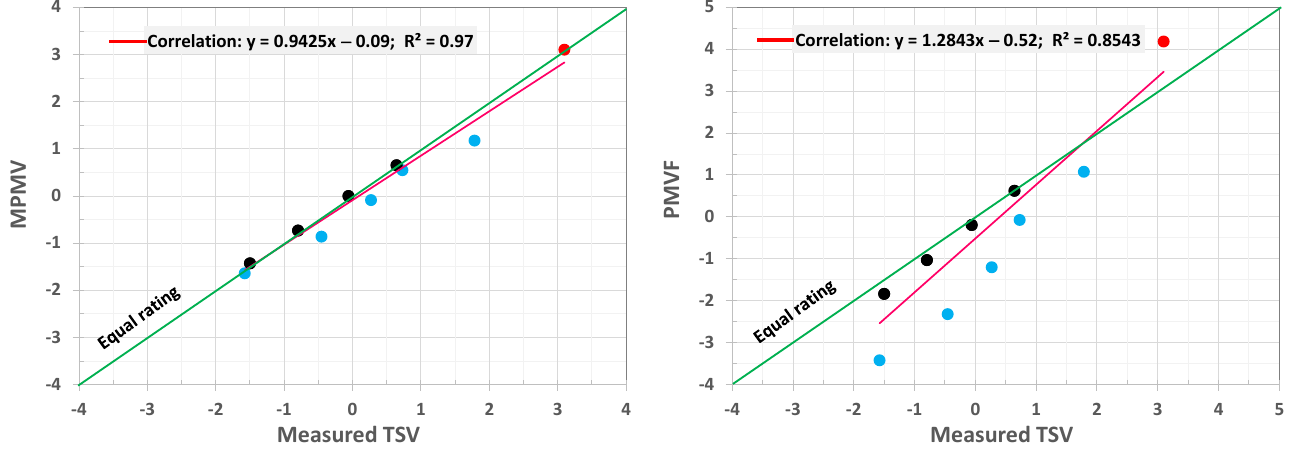
Figure 1. Comparison of MPMV and Fanger’s PMVF with the measured TSV of young adults. Figure 2 compares the MPMV and PMVF with the measured TSV for older people. The MPMV predictions are well aligned with the measured TSV data (R 2 = 0.97 and slope = 0.94). The predictions of the PMVF are, however, not well aligned with the measured data (R 2 = 0.85), resulting in an overestimation of TSV, particularly for older people having significantly lower metabolic rate (data of [44]).